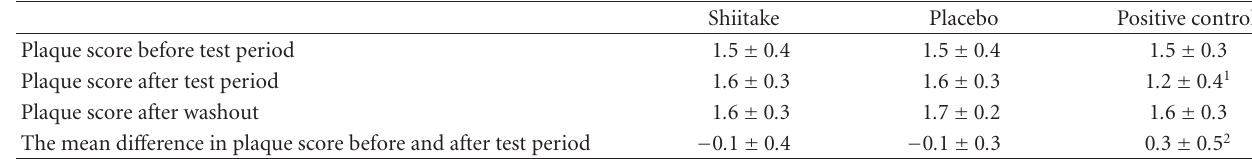
Table 3: Silness & L¨oe plaque index score (as modified by Danser et al. [24]) before and after each of the three legs of the crossover (shiitake, placebo, positive control (AmF-SnF 2 )) and three washout periods (washout shiitake, washout plaque, and washout positive control) for ACTA ( n = 35). Mean ±